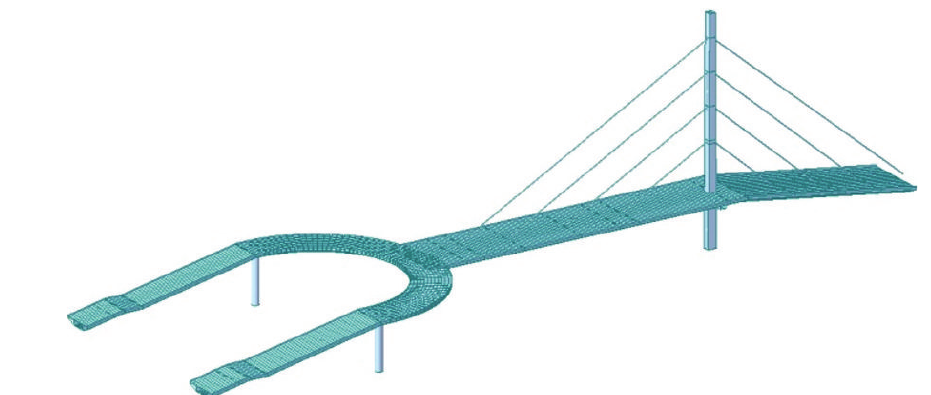
Figure 10: The finite element model of Ligong